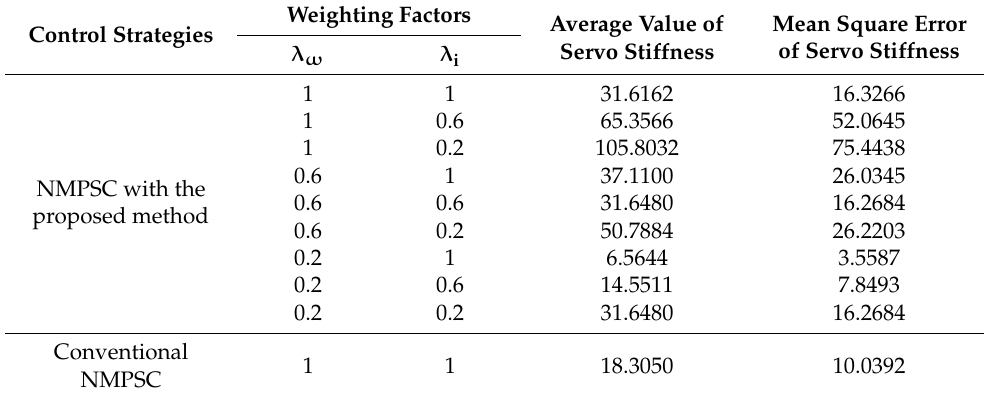
Table 4. Comparison of servo stiffness with different weighting factors.